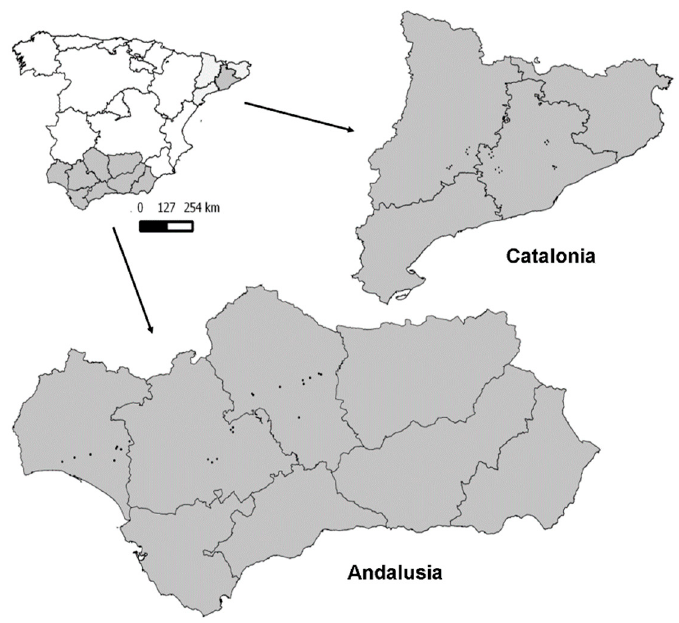
Figure 1. Location of the sampled cereal fields in Andalusia (23 fields) and Catalonia (24 fields). The soils of the sampled fields were alkaline, with textures varying from clayish to sandy loam. The main land-uses in the 1 km radius circular sector around sampled fields in the Andalusia area were arable land (mean value 61.3%), followed by olive orchards, vineyards, and human settlements. In the Catalonian area, the main land-uses were arable land (75.6%) followed by woodland, other